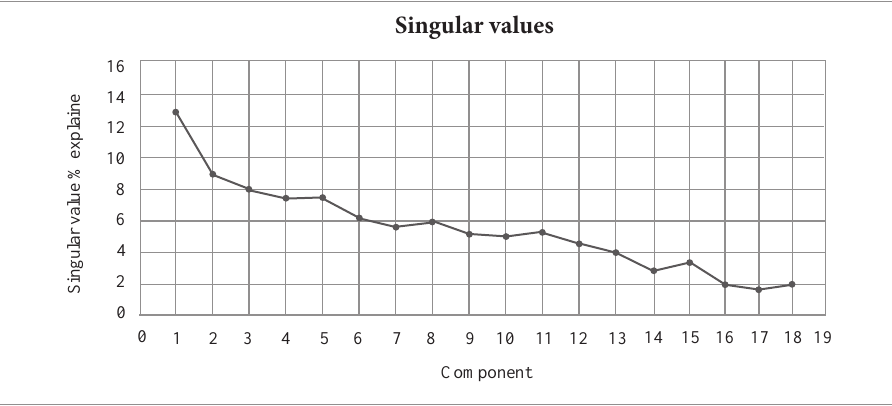
Fig. 6. Importance of following components in SVD